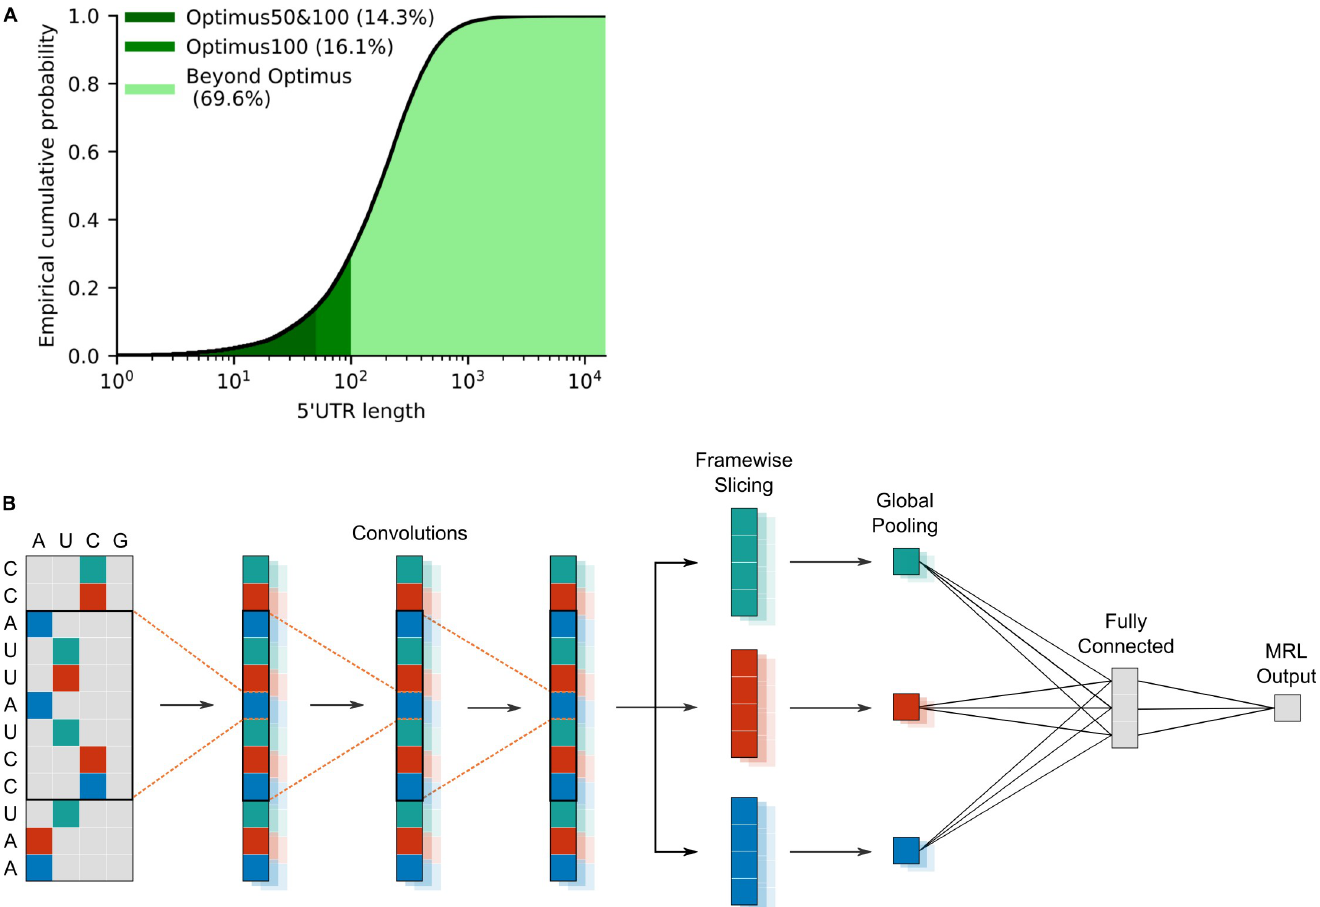
Fig 1. Modelling 5’UTR of any length. A) Empirical cumulative distribution of human 5’UTR lengths, according to GENCODE v19: only 14% (for Optimus50), or 30% (for Optimus100) of human 5’UTR sequences can be quantified by an Optimus model without information being lost due to truncation. B) Schematic of a frame pooling model: a one-hot-encoded 5’UTR is fed through 3 convolutional layers. For ease of visualization, the biological frame is indicated by colour. Then the convolution output is sliced according to the frame, and each frame is pooled separately, using global average and max pooling. The frame-specific information is then aggregated by a dense layer and a final linear layer assembles the mean ribosome load